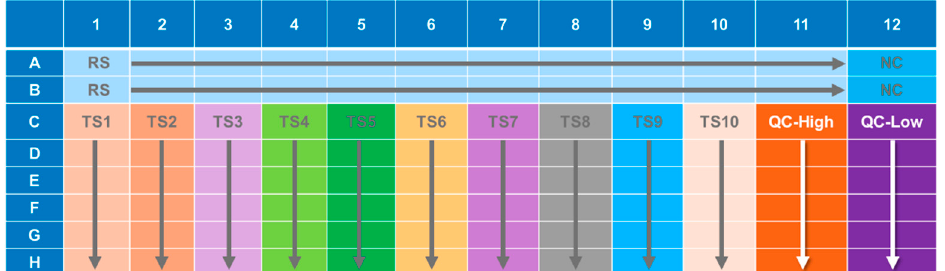
Figure 1. Illustration of General Anti-GP IgG ELISA Method.